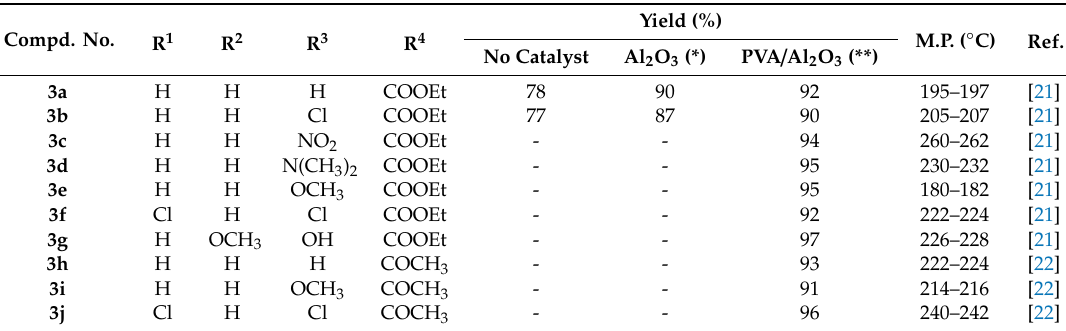
Scheme 2. Synthesis of thiazole derivatives 3a – j. Table 3. Yield percent of products 3a – j.